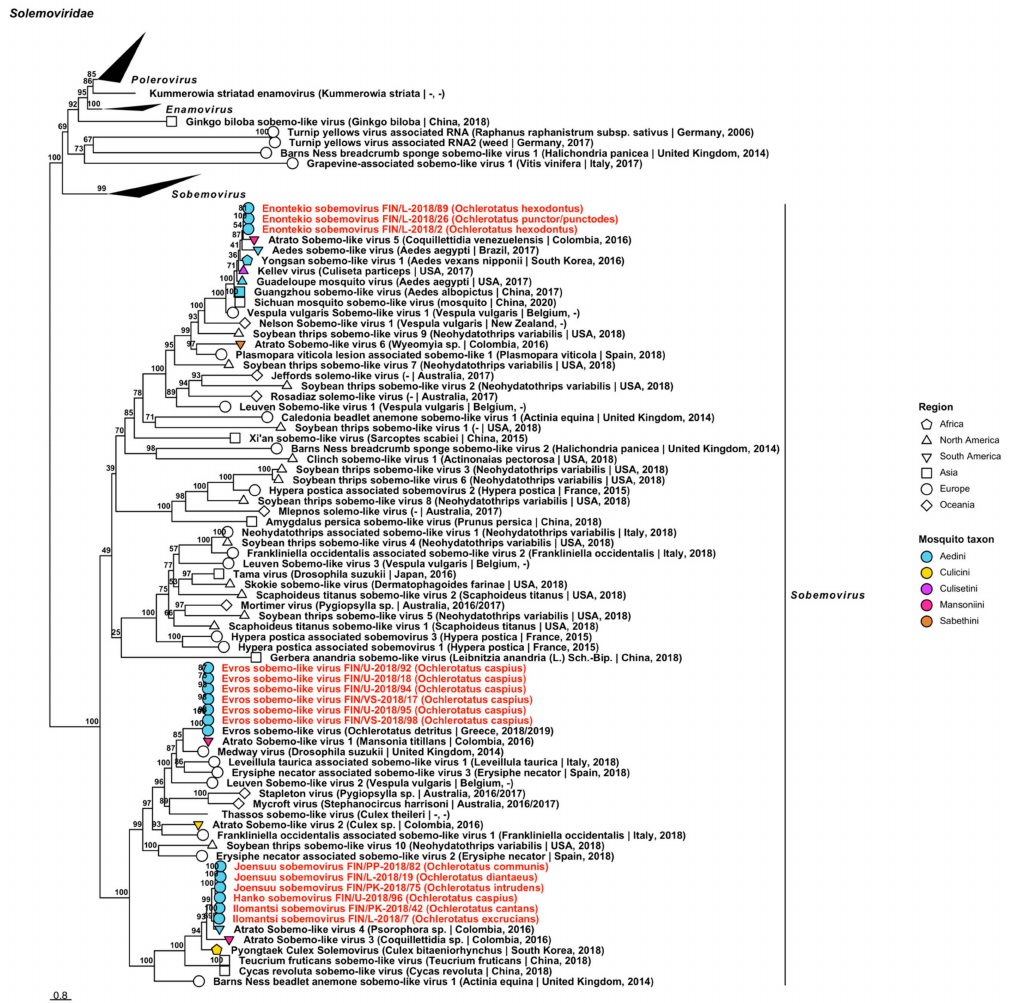
Figure 7. Maximum likelihood tree of Solemoviridae . Tentative novel viruses are displayed in red and the mosquito species from which they were derived are in parentheses. Sequences from GenBank are black and display the following information after the virus or species name: “(sampled organ- ism(s)|collection country, collection year)”. Tip colours represent the tribe of mosquito from which viruses were obtained. Tip shape represents the continent or region from which the specimens were collected. Trees were constructed from amino acid sequences of virus polymerases >1000 nt, aligned with MAFFT and computed with IQ-TREE2 using ModelFinder and 1000